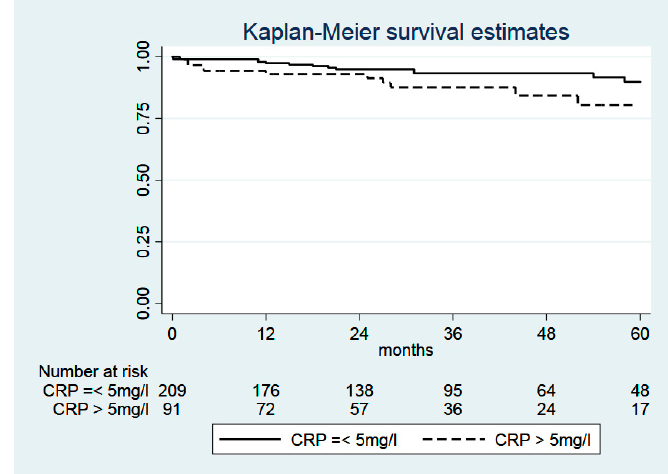
Figure 2. Kaplan–Meier curves comparing the non-cancer-related survival of patients with CRP ≤ 5 mg/L ( n = 209) and with CRP >5 mg/L ( n = 91). Log-rank test: χ 2 = 1.2, p = 0.271. Abbreviation: CRP, C-reactive protein.